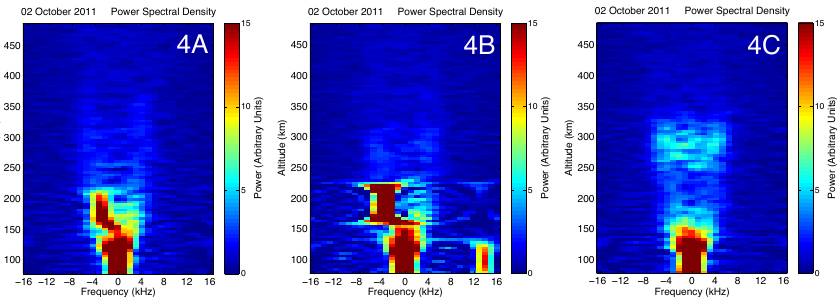
Figure 13. Event 4: NEIAL spectra from the times labeled 4A–4C in Fig. 12. The lower-altitude NEIAL has a highly asymmetric spectrum, while the higher-altitude NEIAL has no specific asymmetry and contains power throughout the region between the ion-acoustic peaks.